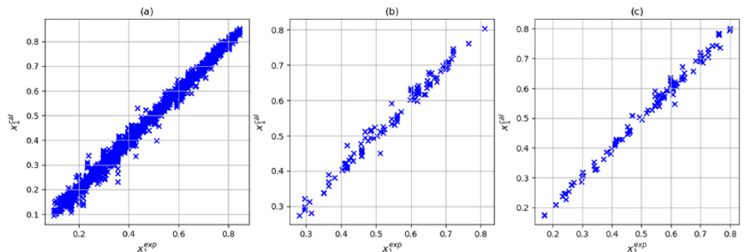
Figure 5. Correlation between experimental data and those calculated by ANN using T, P, Tc, and Pc inputs with (4,6,8,1) architecture: ( a ) training dataset, ( b ) testing dataset, and ( c ) prediction dataset.